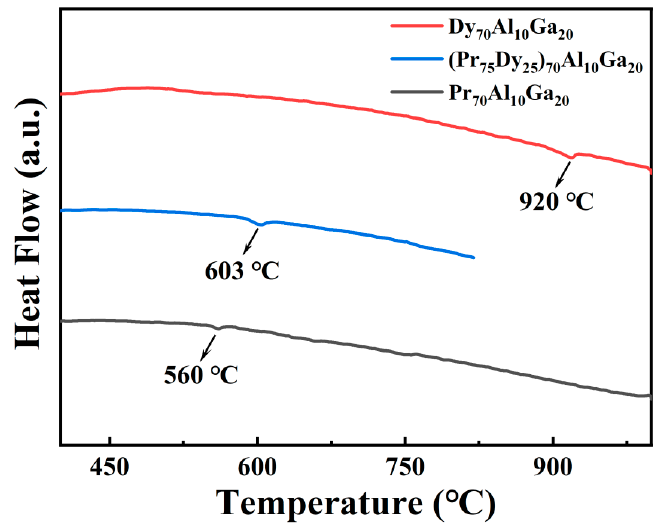
Figure 1. DSC results of Dy 70 Al 10 Ga 20 , (Pr 75 Dy 25 ) 70 Al 10 Ga 20 , and Pr 70 Al 10 Ga 20 ribbons.